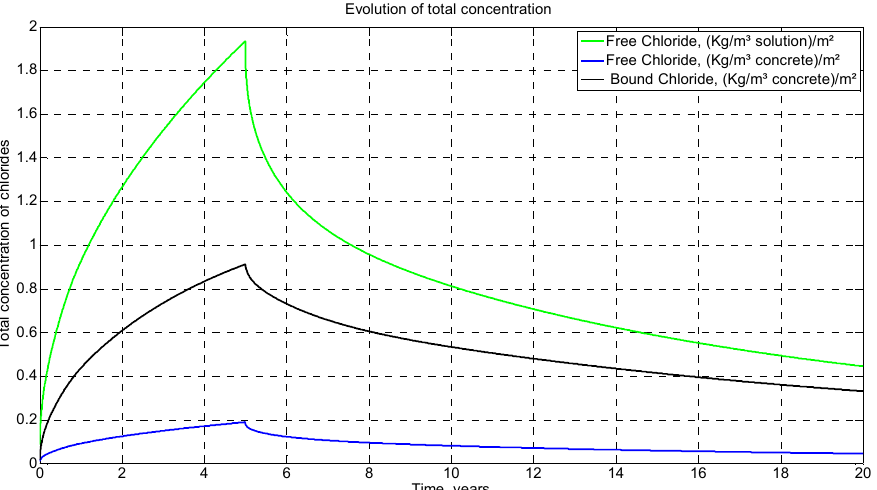
Figure 19. Time dependent of total chloride of C f,s (free chloride in kg/m 3 solution), C f,c (free chloride in kg/m 3 concrete) and C b (bound chloride in kg/m 3 solution) that penetrates the boundary. Table 6. Unsaturated problem. Data of the third